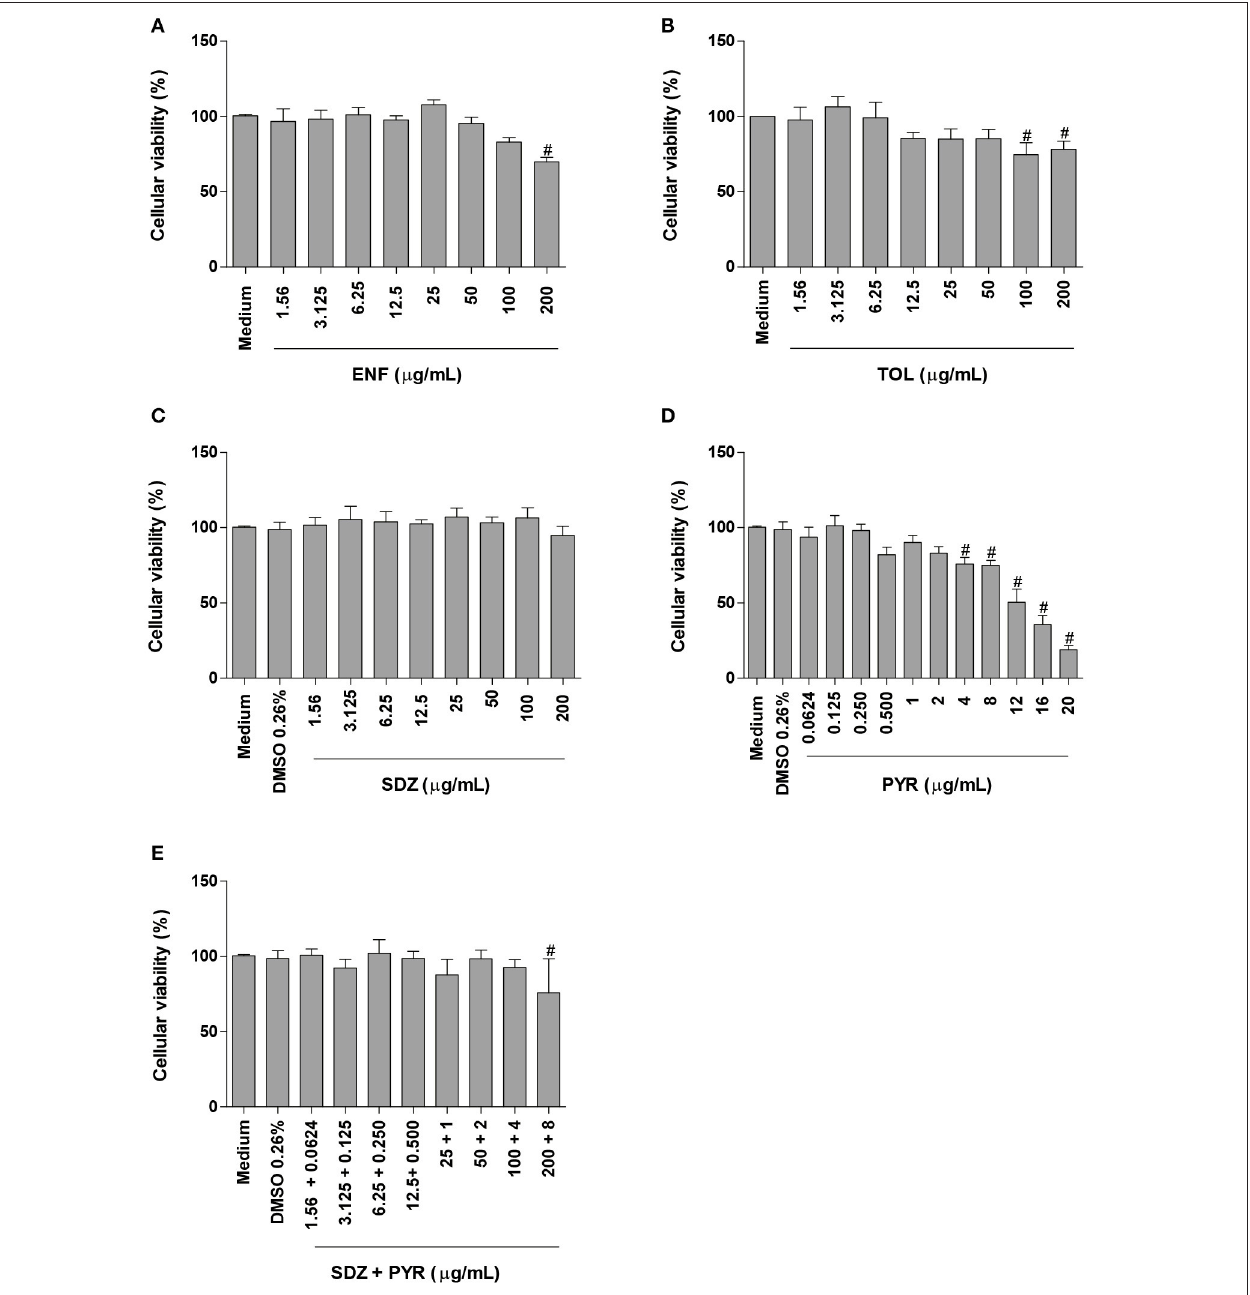
FIGURE 1 | Cellular viability in BeWo cells treated with different drugs. BeWo cells were cultured in 96-well plates (3 × 10 4 cells/well/200 µ L) for 24 h and treated or not with DMSO (0.26%), enrofloxacin (ENF) (A) , toltrazuril (TOL) (B) , sulfadiazine (SDZ) (C) , pyrimethamine (PYR) (D) , or combination of sulfadiazine plus pyrimethamine (SDZ + PYR) (E) in different concentrations ( µ g/mL). After 24 h of treatment, the cells were submitted to MTT assay and data were presented as percentage (%) of viable cell (cellular viability) in relation to untreated cells (100% of cellular viability). Data were shown as mean ± SEM from three independents experiments with nine replicates. Significant differences in relation to untreated cells (medium) ( # P < 0.05). Differences between groups were analyzed by One-Way ANOVA with the Bonferroni multiple comparison post-hoc test.